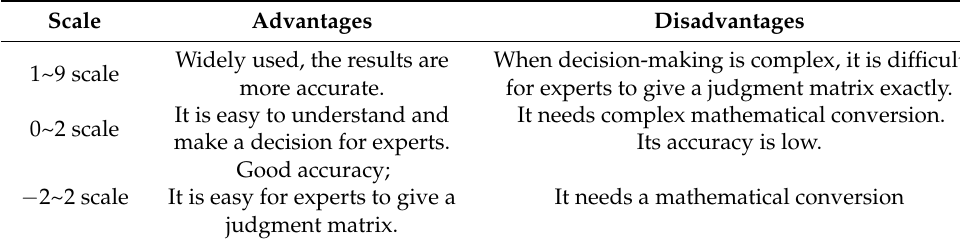
Table 2. Comparison of the 1 ∼ 9 scale, − 2 ∼ 2 scale and 0 ∼ 2 scale.